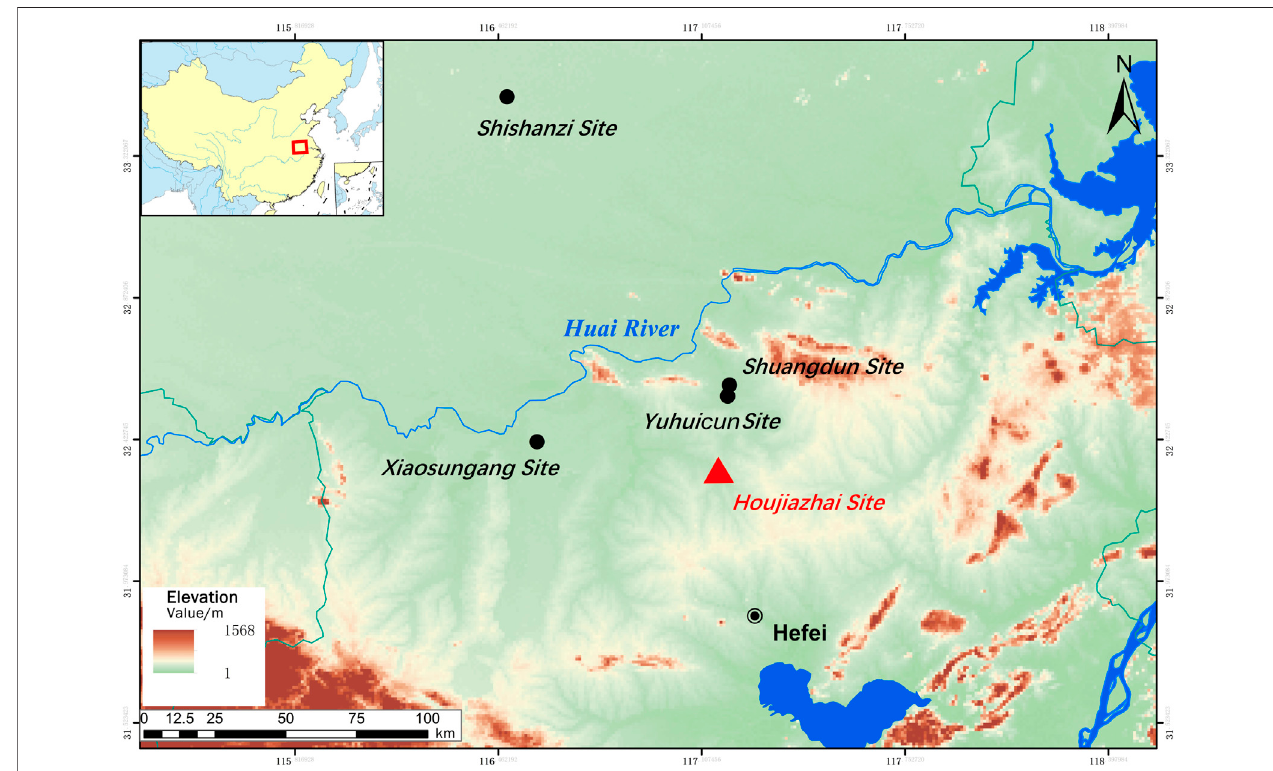
FIGURE 1 | The locations of the site of Houjiazhai and other sites associated with the Shuangdun Culture in the Middle Huai river valley.